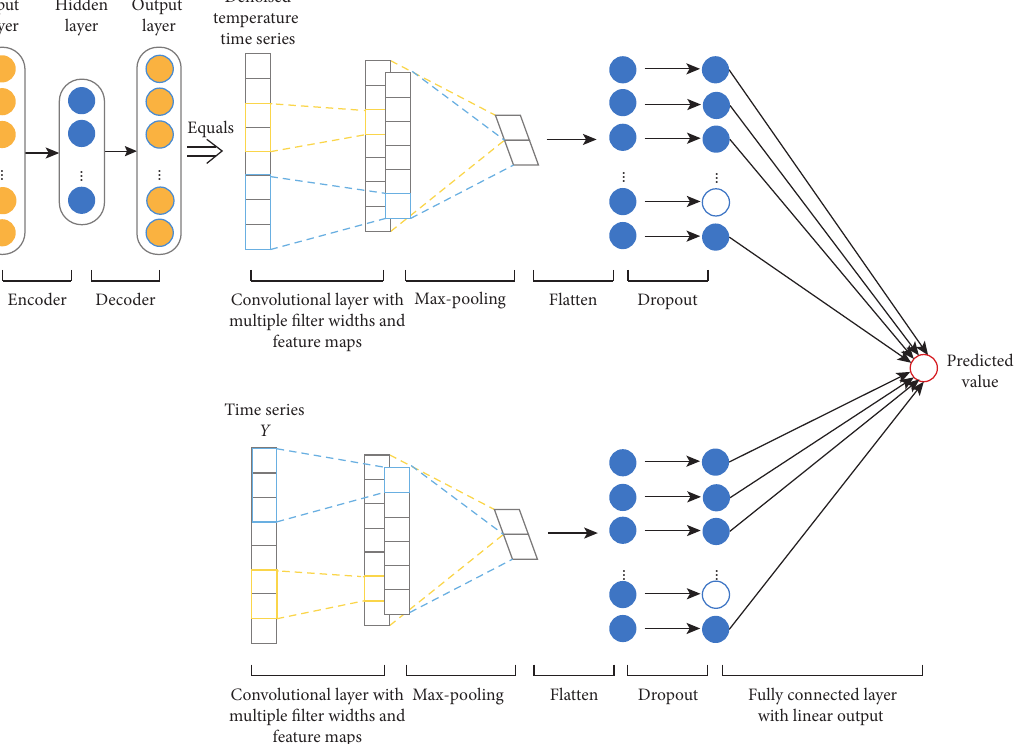
Figure 2: The architecture of